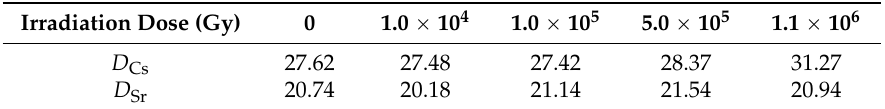
Table 5. The effect of irradiated extractants on D Cs and D Sr .